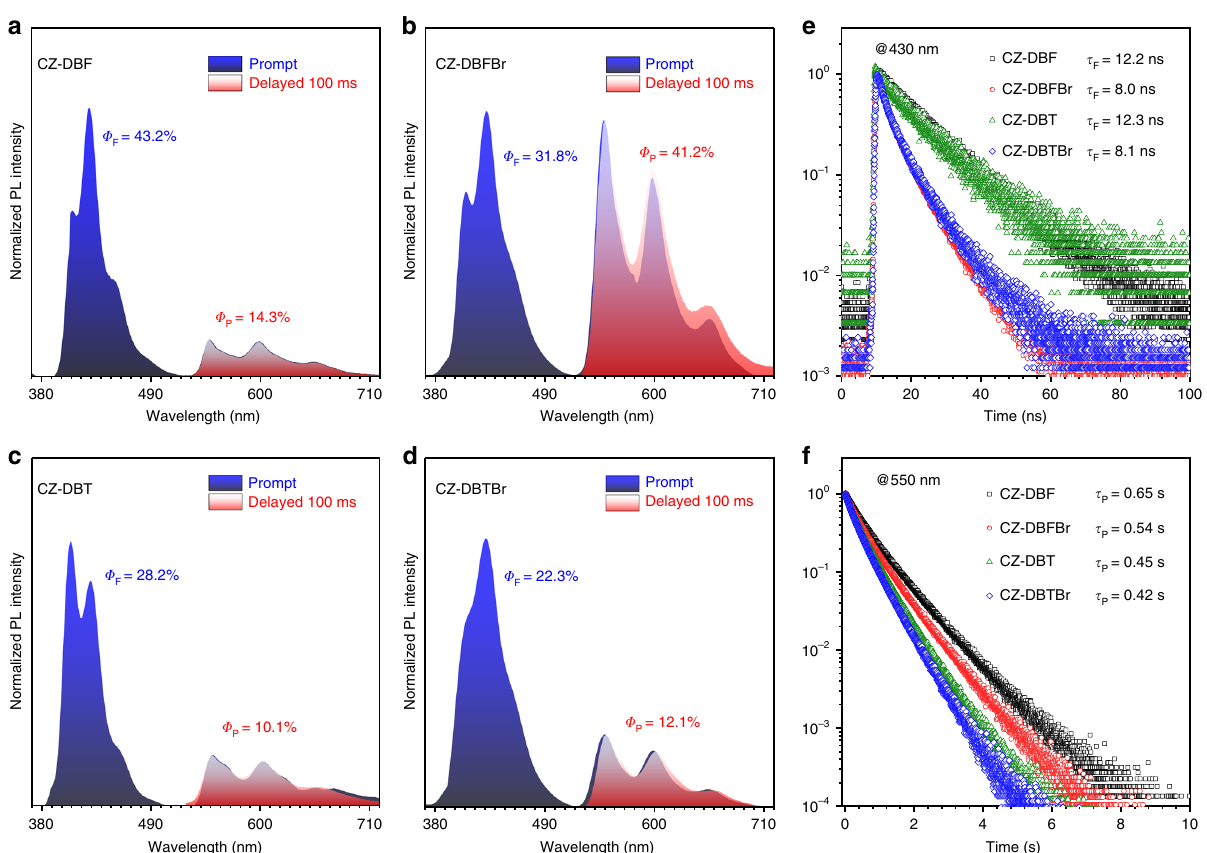
Fig. 3 Photophysical properties of CZ-DBF, CZ-DBFBr, CZ-DBT, and CZ-DBTBr. a – d , The prompt (blue zone) and delayed (red zone, 100 ms) PL spectra of the crystalline powders of CZ-DBF ( a ), CZ-DBFBr ( b ), CZ-DBT ( c ), and CZ-DBTBr ( d ) with Φ F and Φ P inset. Note that the red zones are perfectly overlapped with the longer ranges of the blue zones. e, f , Transient PL decay curves of CZ-DBF, CZ-DBFBr, CZ-DBT, and CZ-DBTBr measured at 430 nm ( e ) and 550 nm ( f ) with τ inset. The excitation was 365